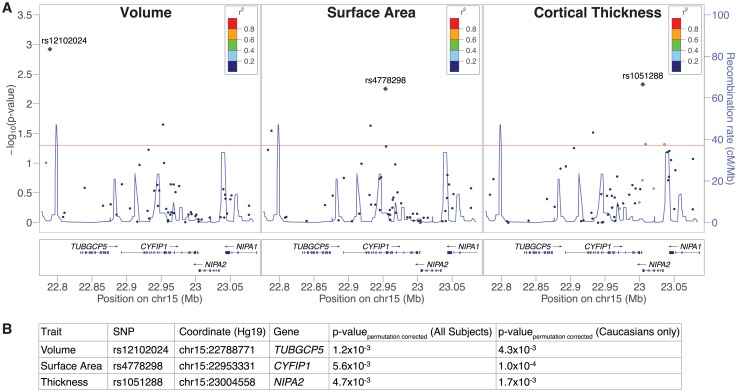
Common variant genotypes at 15q11.2 arssociated with differences in regional cortical volume, thickness, and surface area in a discovery cohort.(A) Aggregate -log p-values for single nucleotide polymorphisms (SNPs) are plotted against genomic position. P-values reflect the relationships between genotype in the discovery cohort and volume (left), surface area (middle), or thickness (right) across all regions of interest (ROIs). Significant associations (ppermutation corrected<0.05) appear above the horizontal red line. Linkage disequilibrium of top hits (diamonds) to typed variants is specified, and estimated recombination rates plotted (blue lines). r2 in the legend indicates the correlation between genotype at each tag-SNP (circles) and genotype at the top hit (diamond). (B) Top aggregate p-values and their SNP descriptions for each trait examined in the full cohort and the Caucasian subset are summarized.